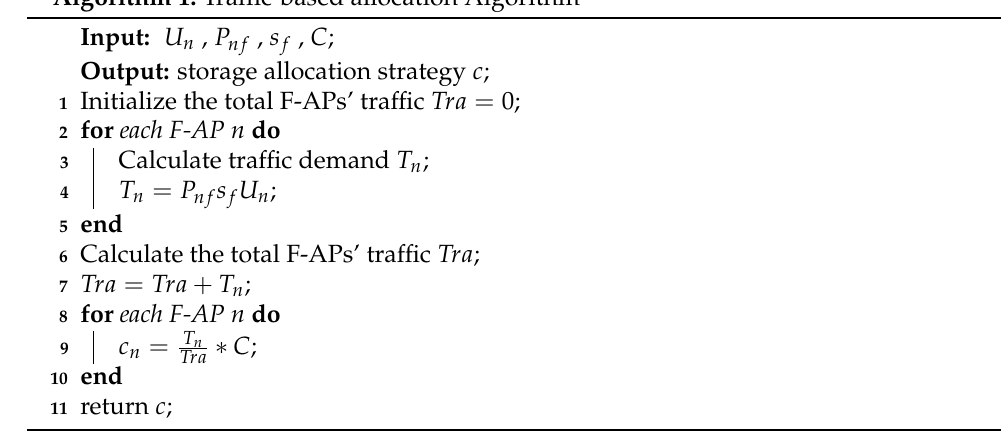
Algorithm 1: Traffic-based allocation Algorithm